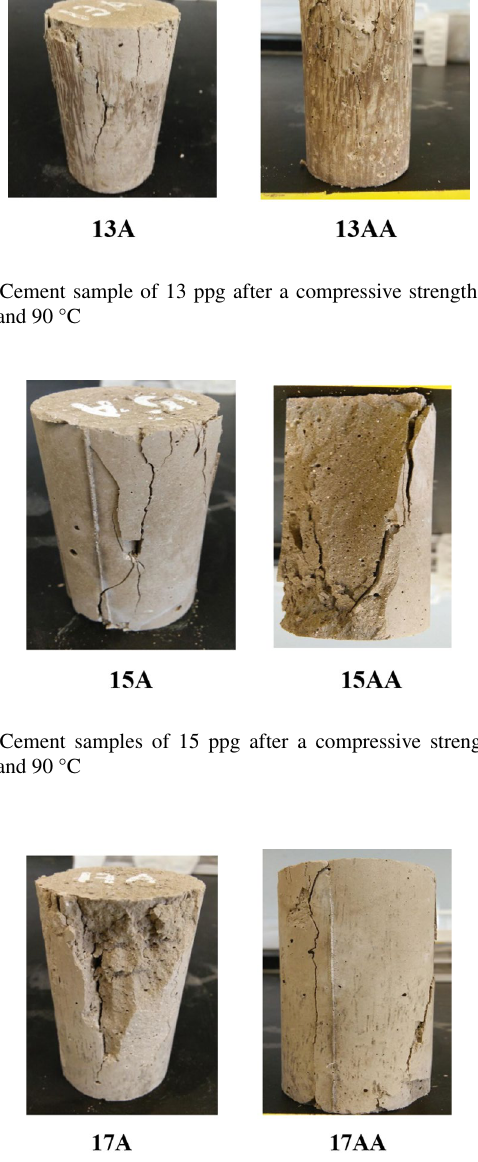
Fig. 4 Cement samples of 17 ppg after a compressive strength test 60 °C and 90